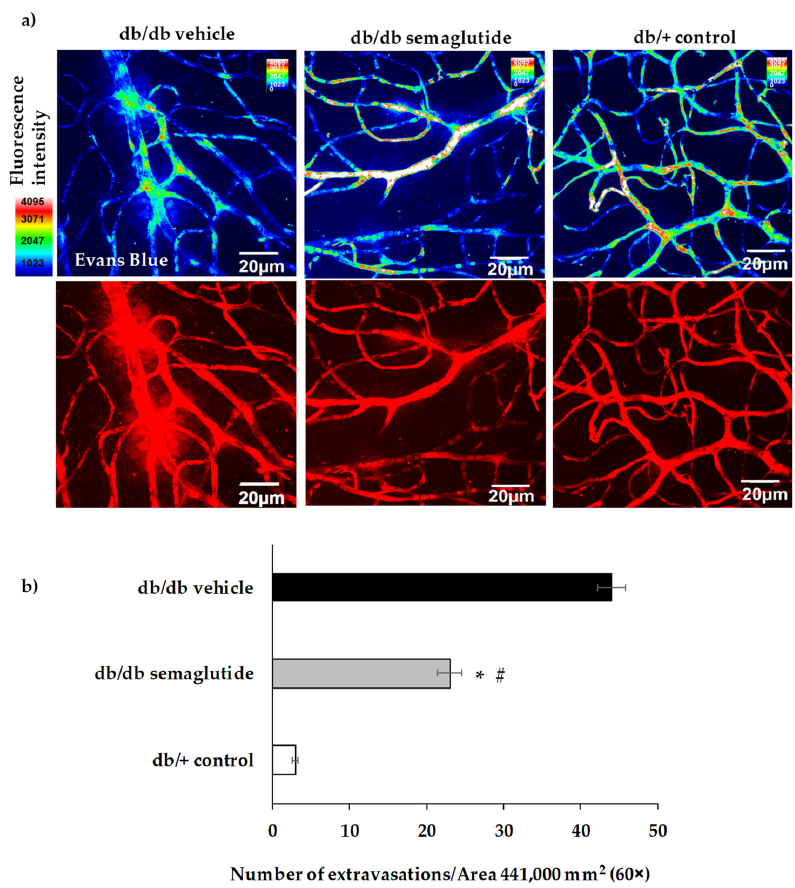
Figure 3. Effect of semaglutide eye drops on vascular leakage. ( a ) Confocal immunofluorescence images of vascular permeability assessed by Evans Blue dye leakage in retinal whole mounts. Spec3, fluorescent spectral signature 3. FI: fluorescence intensity. Scale bars, 20 μm. ( b ) For quantification, the number of extravasations per field of 60× retina was counted. * p < 0.05 in comparison with vehicle. # p < 0.05 in comparison with control.